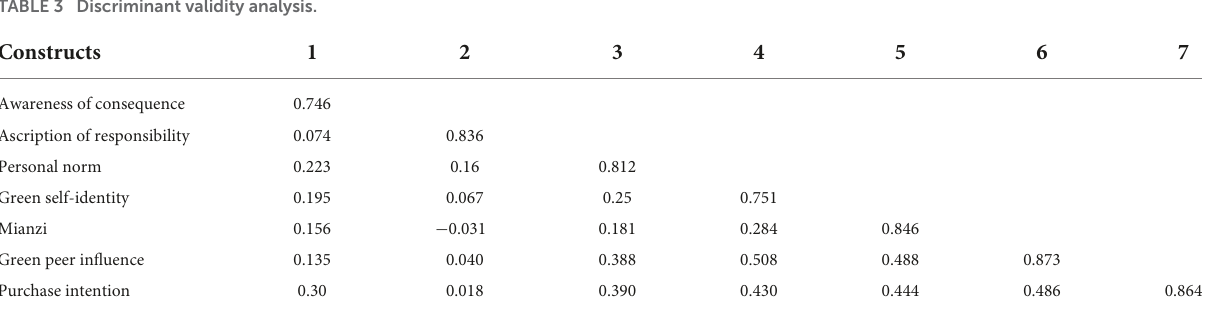
TABLE 3 Discriminant validity